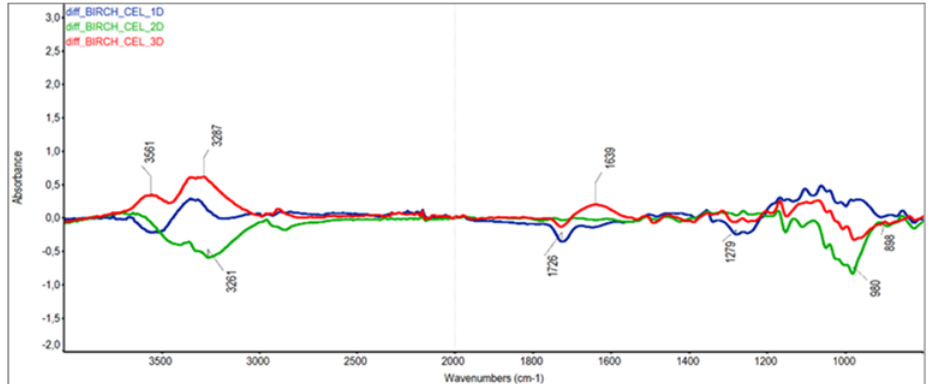
Figure 6. The absorption difference spectra of Seifert’s cellulose.